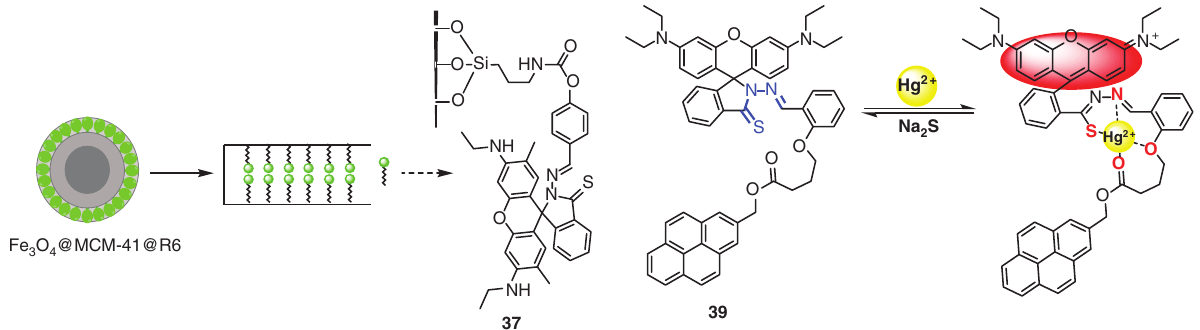
Figure 26: Recognition mechanism of probe 39 with Hg 2 +